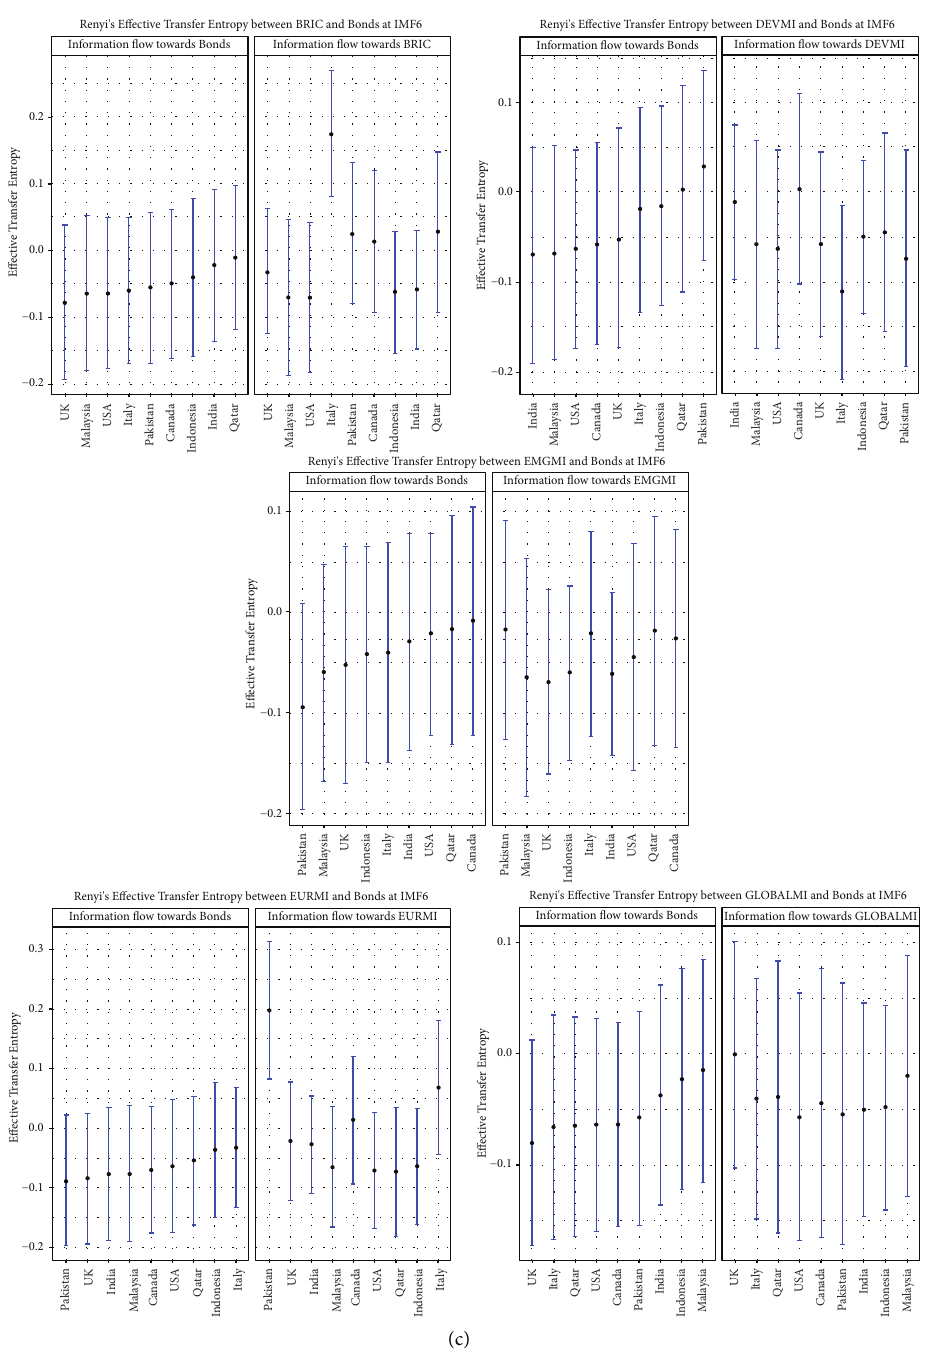
Figure 5: Transfer entropies between bonds and global equities at the frequency-domain level (IMFs 2, 4, and 6). (a) Renyi’s effective transfer entropy between BRIC and bonds at IMF2, (b) Renyi’s effective transfer entropy between DEVMI and bonds at IMF2, (c) Renyi’s effective transfer entropy between EMGMI and bonds at IMF2, (d) Renyi’s effective transfer entropy between EURMI and bonds at IMF2, (e) Renyi’s effective transfer entropy betweenGLOBALMIandbondsatIMF2,(f)Renyi’seffectivetransferentropybetween BRICandbondsatIMF4, (g)Renyi’seffectivetransferentropy between DEVMI and bonds at IMF4, (h) Renyi’s effective transfer entropy between EMGMI and bonds at IMF4, (i) Renyi’s effective transfer entropy between EURMI and bonds at IMF4, (j) Renyi’s effective transfer entropy between GLOBALMI and bonds at IMF4, (k) Renyi’s effective transfer entropy between BRIC and bonds at IMF6, (l) Renyi’s effective transfer entropy between DEVMI and bonds at IMF6, (m) Renyi’s effective transfer entropy between EMGMI and bonds IMF6, (n) Renyi’s effective transfer entropy between EURMI and bonds at IMF6, and (o) Renyi’s effective transfer entropy between GLOBALMI and bonds at